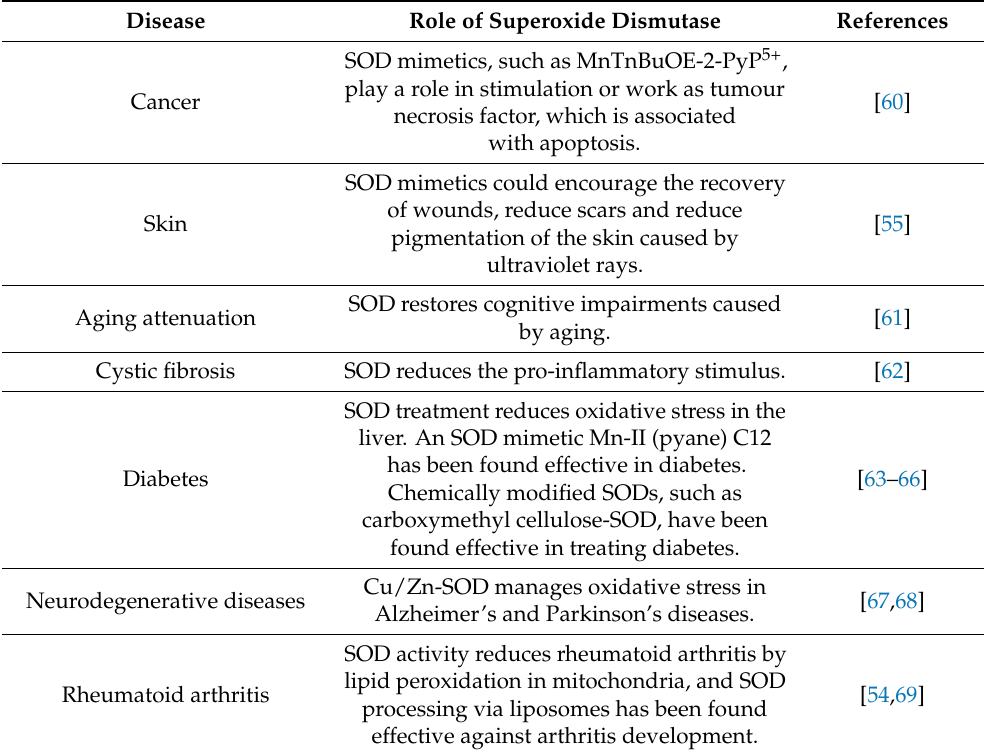
Table 2. Human disease management using SOD